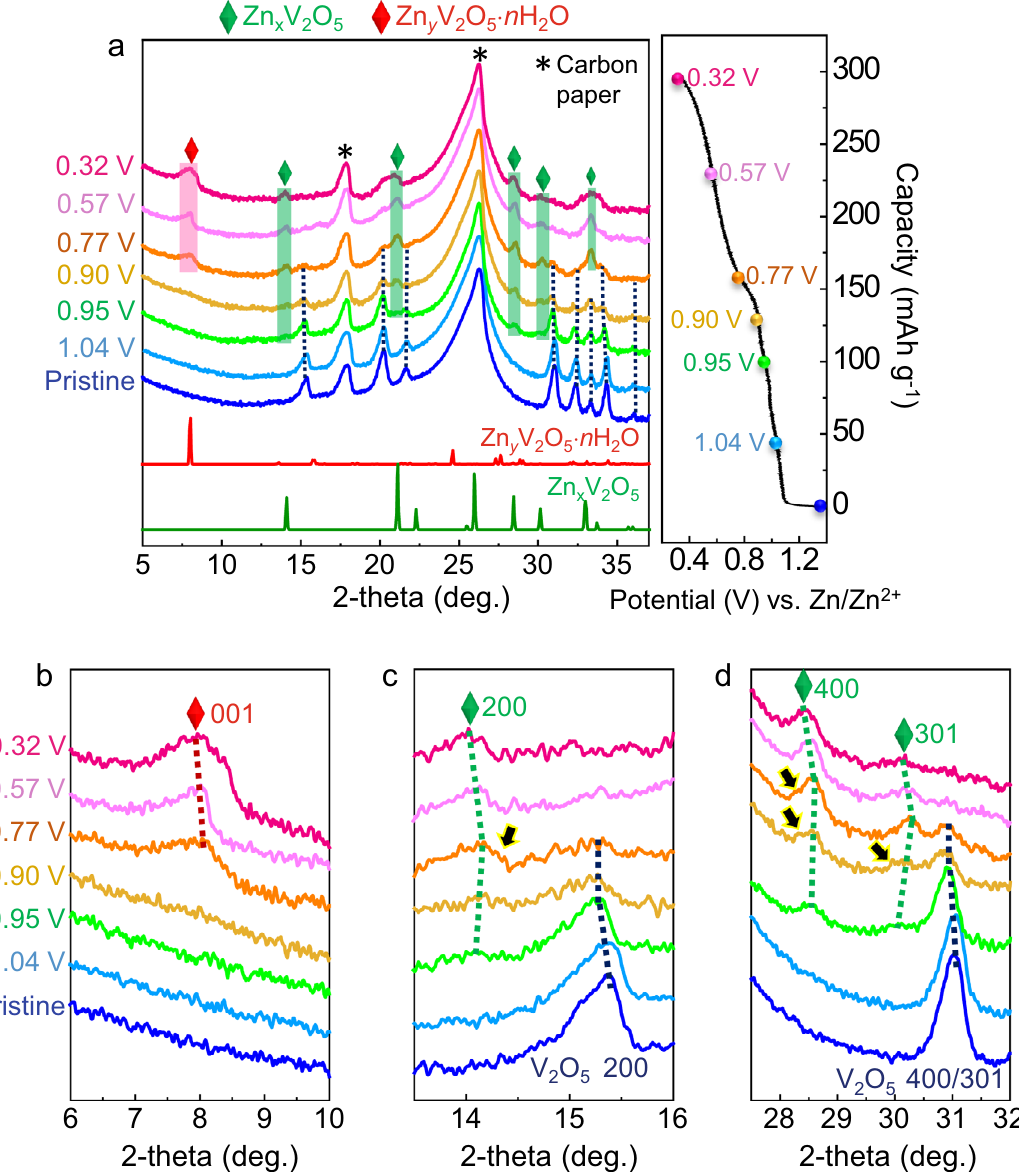
Fig. 1 Series X-ray powder diffraction patterns of V 2 O 5 . a Each ex situ diffraction pattern was obtained at a different discharge voltage, as indicated in the galvanostatic voltage pro fi le. The generation of two Zn-containing phases (Zn x V 2 O 5 and Zn y V 2 O 5 · n H 2 O) during discharge is identi fi ed, as denoted by green and red diamonds. Details of the phase identi fi cation are provided in Supplementary Figs. 1 and 2. b – d The narrow-range enlargements are shown for the major Bragg peaks of the discharged phases. Shifts of the peak position during discharge directly indicate the change in lattice parameters and thereby solid- solution behavior. Black arrows denote unidenti fi ed small shoulder peaks, implying multiple-phase discharge